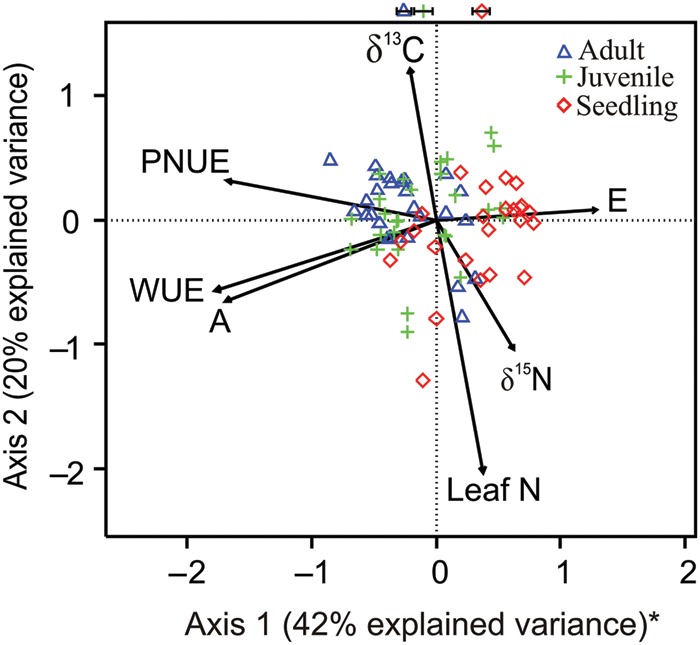
Ordination of functional traits of adults (triangles), juveniles (crosses) and seedlings (rhomboids) using principal component analysis. The combined explained variance of axes 1 and 2 was 62%. *Adults and juveniles were significantly separated from seedling plants along axis 1 using Welch's t-tests (P < 0.05). The position of symbols at the top of the figure indicates mean score values (±SEM, n = 27) of each life stage along axis 1. Full names of traits are given in Table 2.